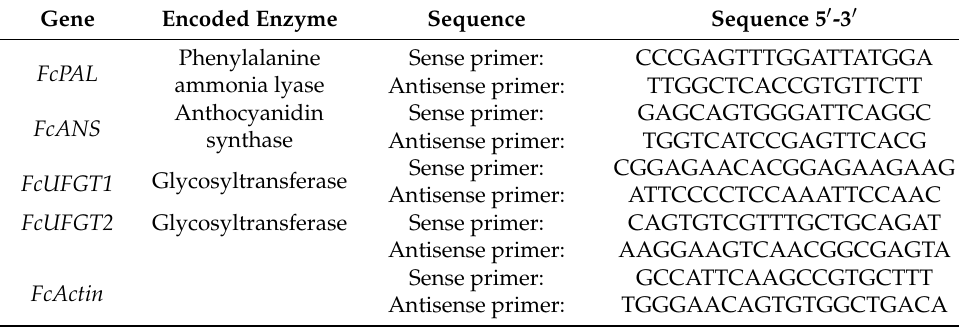
Table 1. Primer sequences used